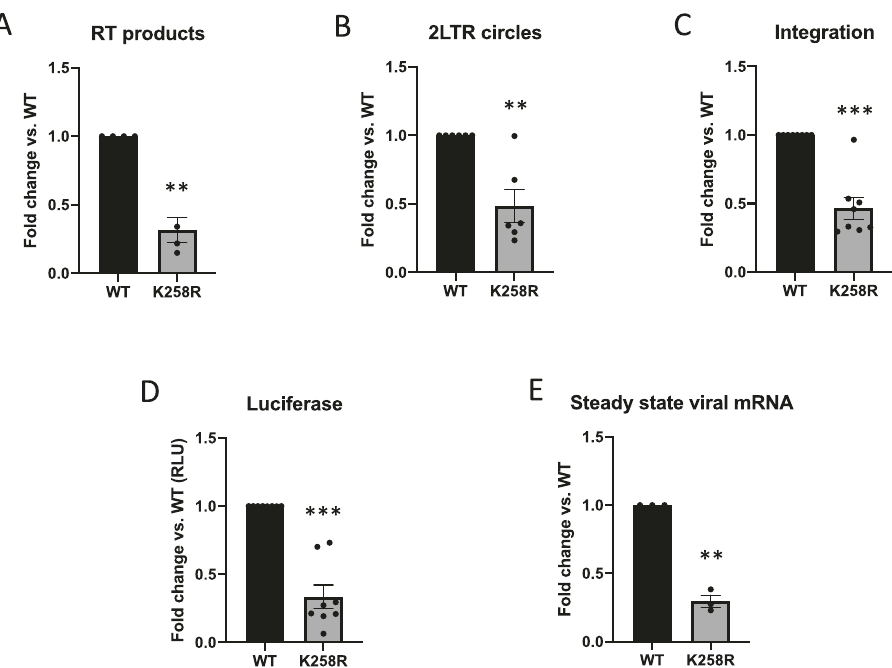
Fig. 1 K258R point mutation in HIV-1 IN has modest effects on early viral replication. HeLa cells were infected with virus generated from pNL4.3.Luc.R-E- carrying either WT or K258R mutant IN. Infected cells were collected at 2 days post-infection. Abundance of ( A ) reverse transcription (RT) products and ( B ) 2-LTR circles was determined by qPCR and normalized to a housekeeping gene ( n = 4 and 6 respectively). C Proviral integration frequency was assayed using a nested PCR Alu-gag approach ( n = 7). D Luciferase activity was measured (RLU) and normalized by protein content to adjust for number of cells in input sample ( n = 8). E Steady state viral mRNA levels were measured by qPCR of infected cellular cDNA using primers against spliced tat message ( n = 3). All data is shown as a fold change relative to WT and is the average of the indicated number of independent biological replicates± SEs. Statistical signi fi cance was gauged by two-tailed paired t test (* p < 0.05; ** p < 0.01; *** p < 0.001). Source data are provided as a Source Data fi le. Table 1 Sum of unique integrations mapped in three biological